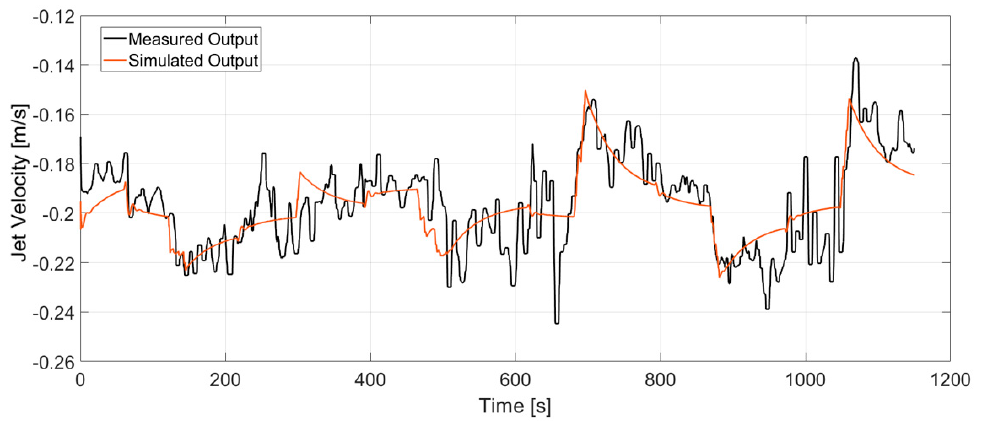
Figure 11. Comparison of the output of identified model with the measured output for jet velocity. The deterministic part of the output relevant for model-based control is captured sufficiently by the model.